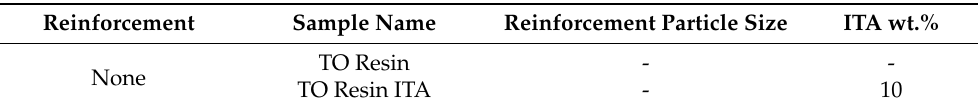
Table 1. Sample names of the composites, their reinforcements and particle sizes, and amount of itaconic anhydride.